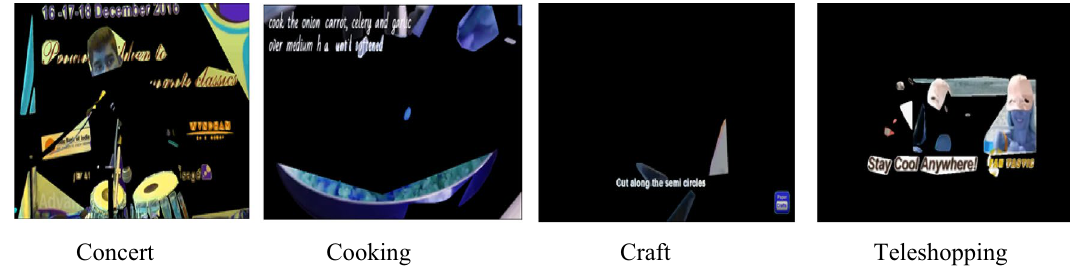
Fig. 3 The result of MSER